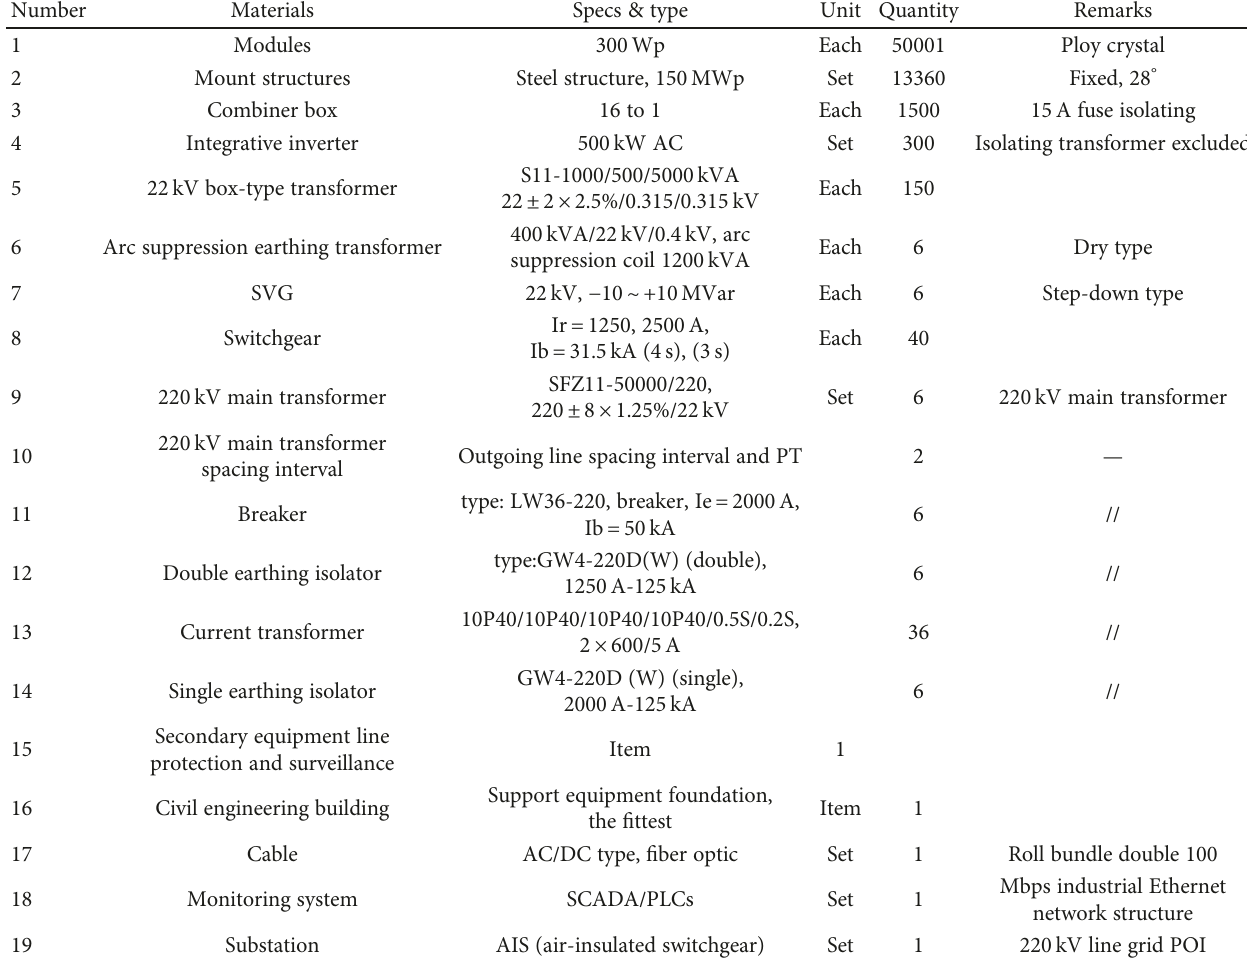
Table 12: Breakdown eBOP ’ s list of 3 × 50MW solar